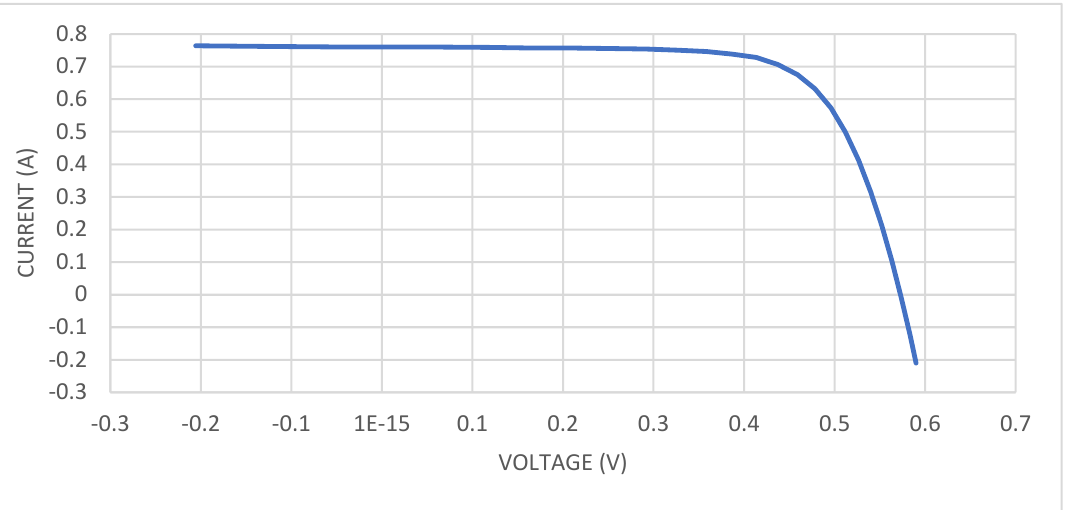
Figure 6. The I-V curve at standard temperature conditions.